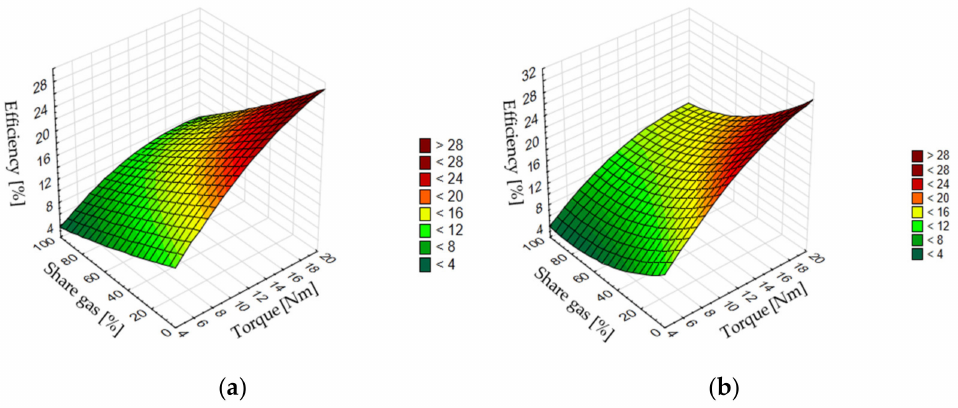
Figure 11. Efficiency of the cogeneration unit for the mixtures: ( a ) DF + LPG and ( b ) RME + LPG.